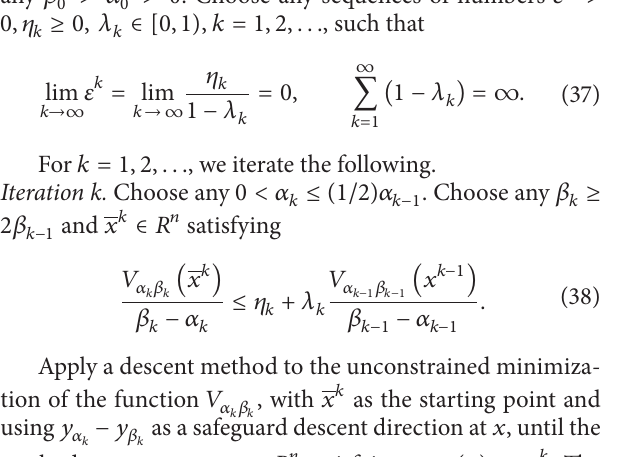
Algorithm 9. Choose an arbitrary initial point 𝑥 0 ∈ 𝑅 𝑛 ,